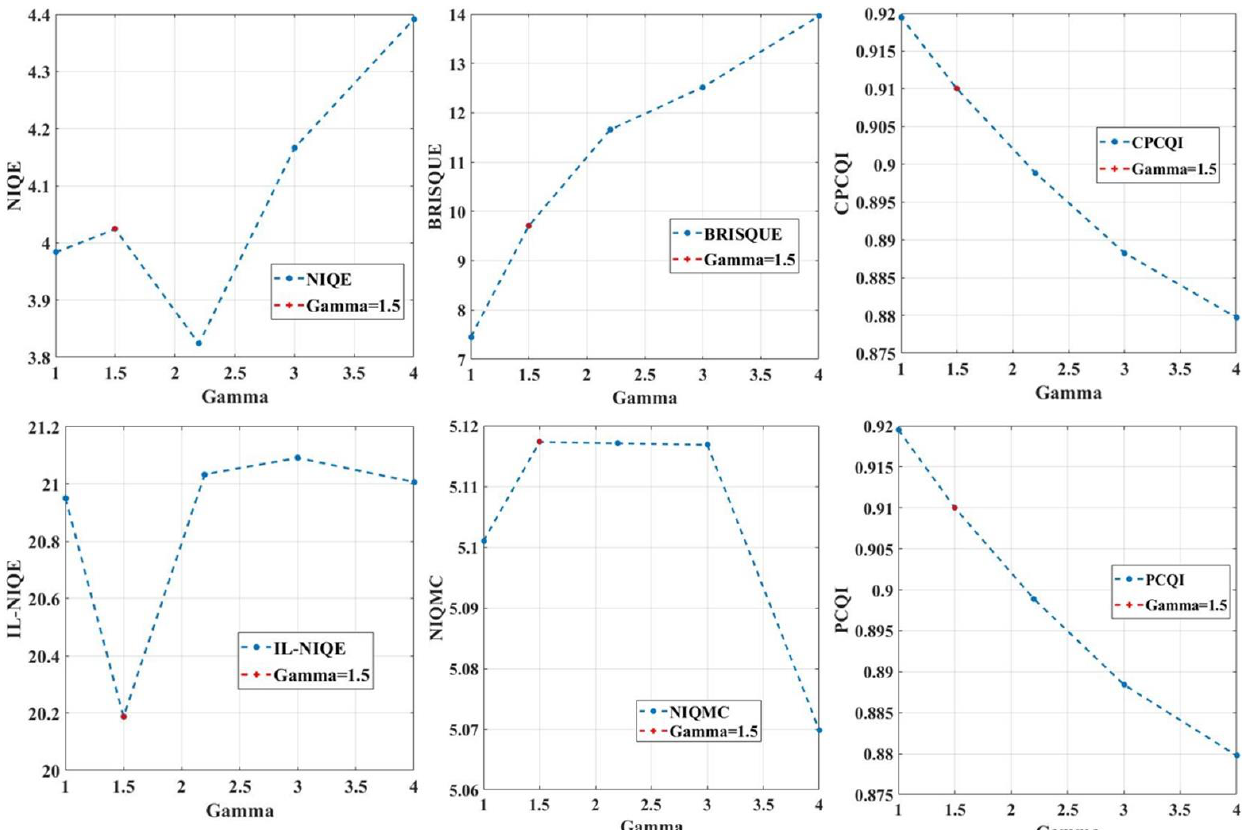
Figure 24. Graphs of six quantitative indicators at different γ